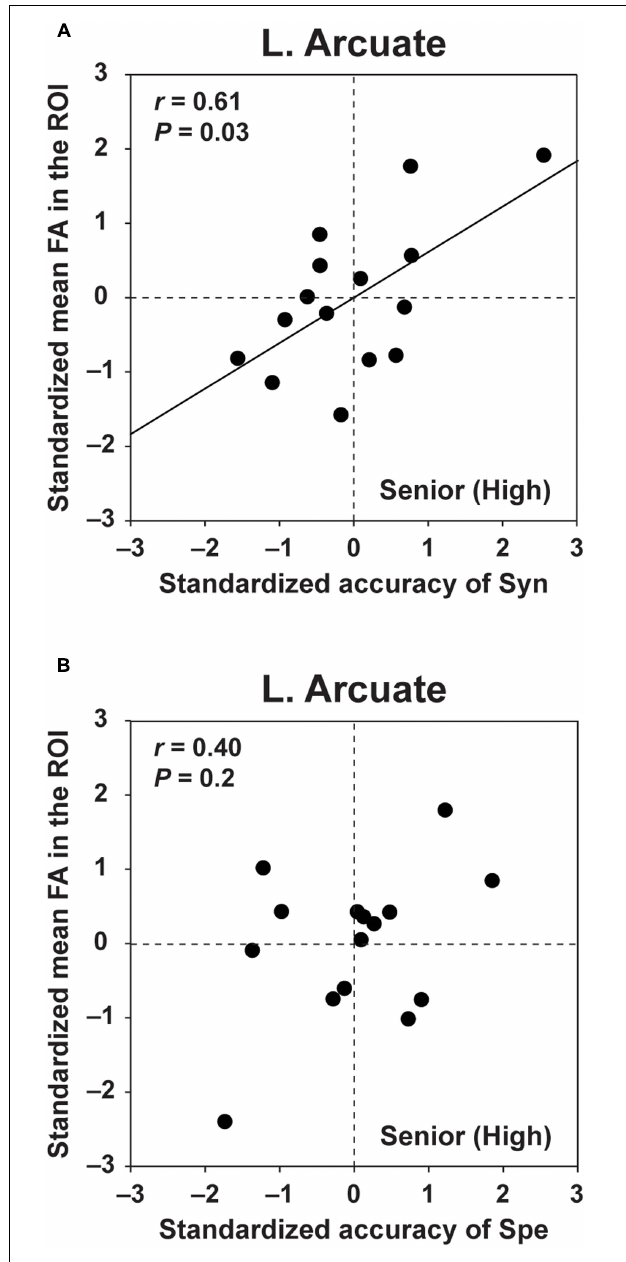
FIGURE 5 | FA in the left Arcuate was selectively correlated with the accuracy of Syn. (A) The scatter plots of the standardized accuracy of Syn and the standardized mean FA in the left Arcuate. The ROIs in the left Arcuate were determined for each participant in the Senior (High) group. The effects of the standardized accuracy of Spe, gender, and laterality quotient (LQ) were removed. (B) The scatter plots of the standardized accuracy of Spe and the standardized mean FA in the left Arcuate. The effects of the standardized accuracy of Syn, gender, and LQ were removed. FA in the left Arcuate was correlated with the accuracy of Syn, but not with the accuracy of